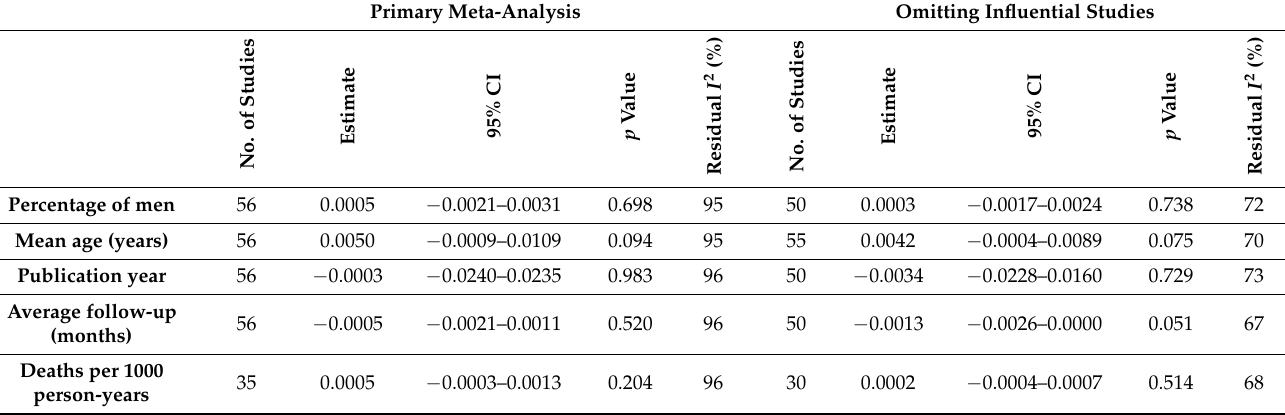
Table 3. Meta-regression models for the association between statin use and all-cause